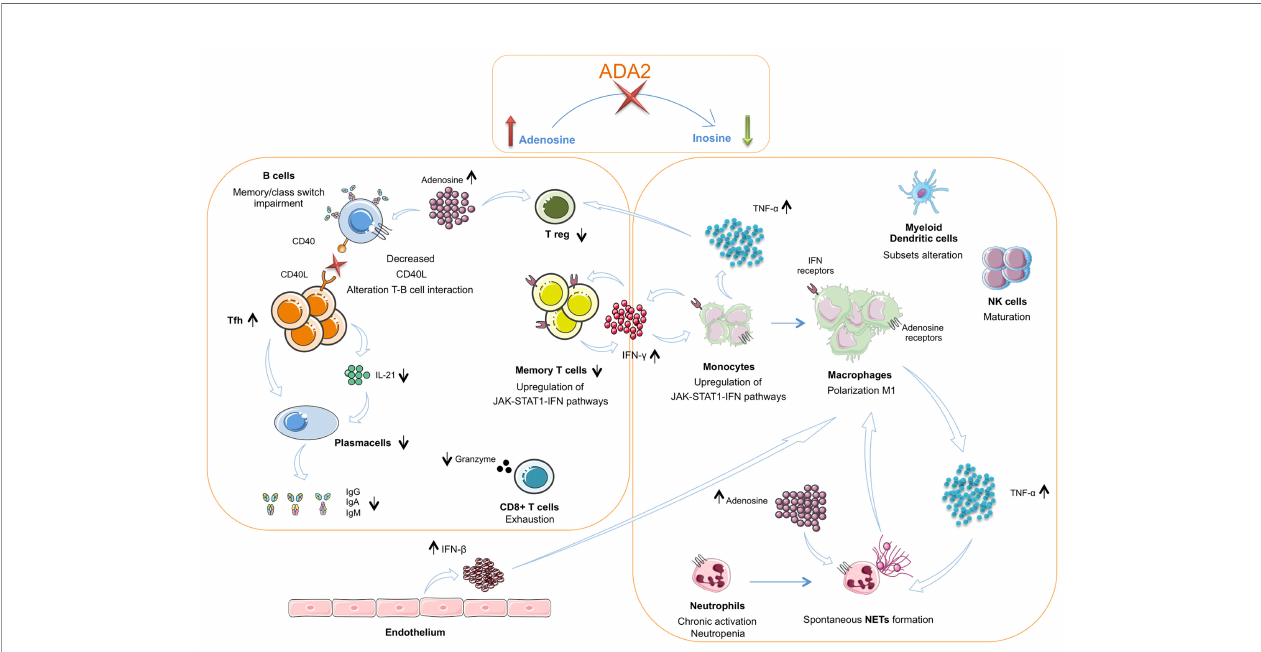
FIGURE 2 | The interplay between innate and adaptive immune cells in DADA2. The insuf fi cient or absent ADA2 enzymatic activity leads to a reduction of adenosine conversion into inosine and to an accumulation of adenosine in the extracellular space. In the innate immune system this leads to a chronic neutrophils activation and NETosis dysregulation with spontaneous NETs formation. Macrophages show a polarization towards the M1 subtype with consequent hypersecretion of in fl ammatory cytokines, especially TNF- a Dysregulation of NETosis and IFN- b secreted in large amount by endothelium also contribute to the M1 polarization. TNF- a acts on neutrophils contributing to maintaining their chronic activation state. CD56bright immature NK cells are increased. Dendritic cells present an altered subsets distribution. TNF- a , together with adenosine, acts also on Treg cells, that result diminished. In the T cell compartment, Tfh cells show an increased frequency but an impaired secretion of IL-21, crucial for B-cell function. Furthermore, T cells present a reduced proportion of the memory subsets and an alteration of CD40L expression. This defect is associated with an impaired B cell proliferation, differentiation and switching with consequent lower levels of immunoglobulins. CD8+ T cells show an exhausted phenotype and produce low amounts of granzyme A. Both T cells and monocytes show an upregulation of JAK – STAT1 – IFN pathways. In monocytes this activation contributes to the M1 macrophage polarization. TNF- a , Tumor necrosis factor a ; IFN b , Interferon b ; NETs, Neutrophils extracellular